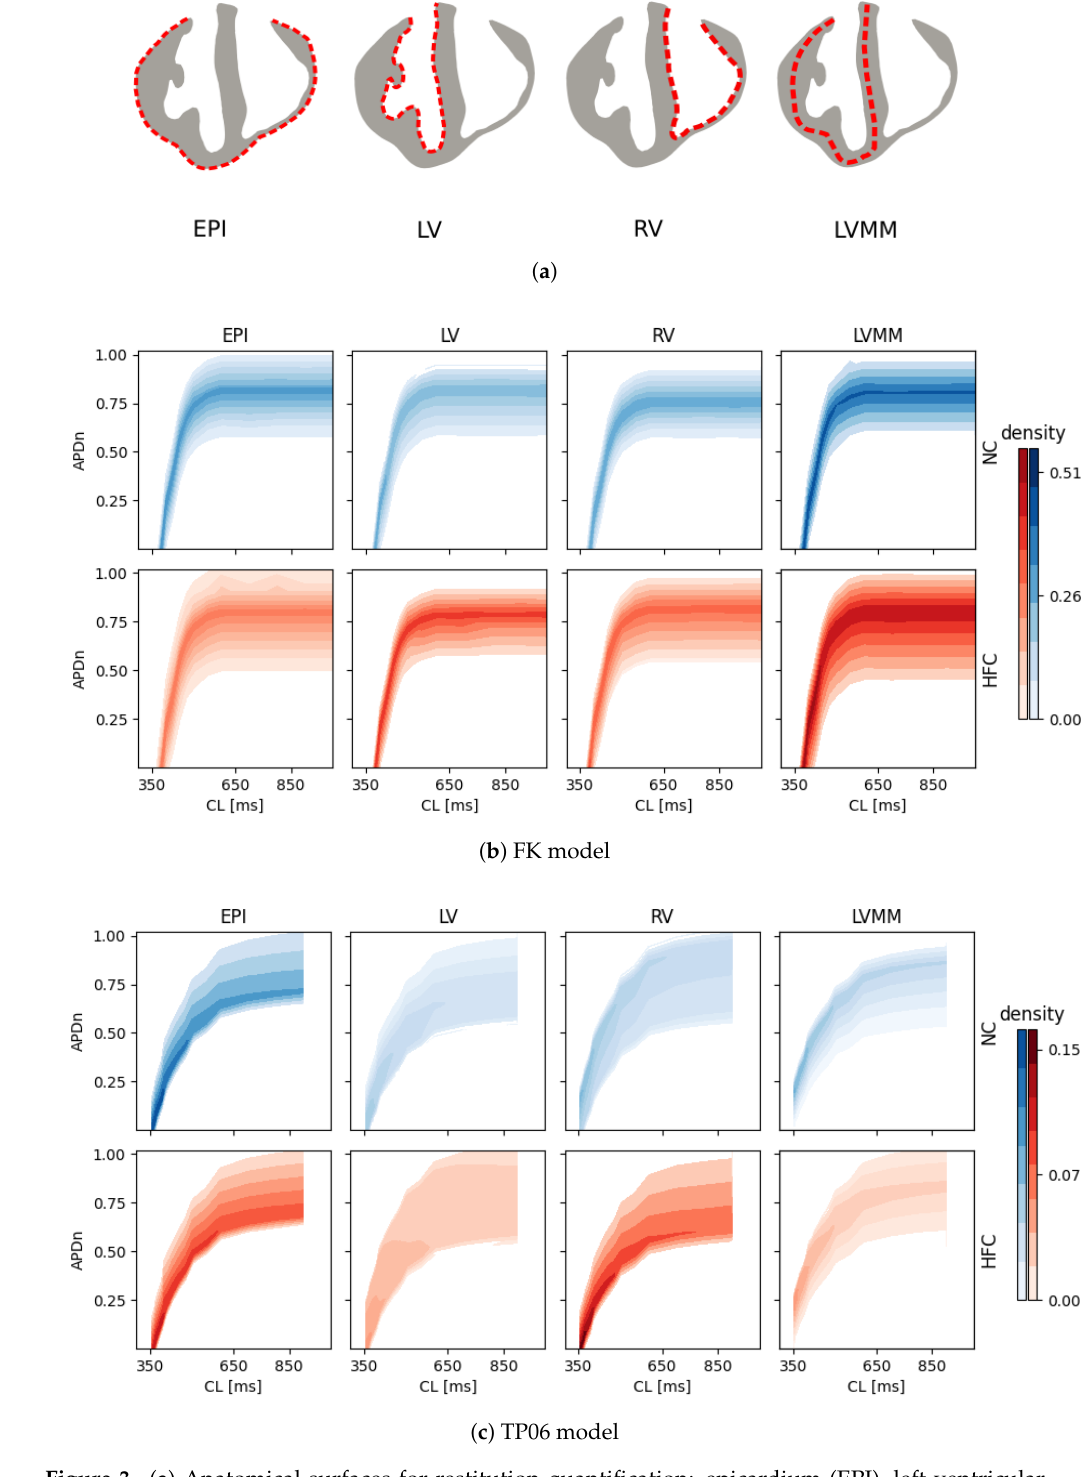
Figure 3. ( a ) Anatomical surfaces for restitution quantification: epicardium (EPI), left ventricular endocardium (LV), right ventricular endocardium (RV), left ventricular mid-myocardium (LVMM). Normalized APD restitution distribution (APD n ) for ( b ) FK and ( c ) TP06 model comparing healthy (NC–blue) and myocardiacl infarcted (HFC–red)